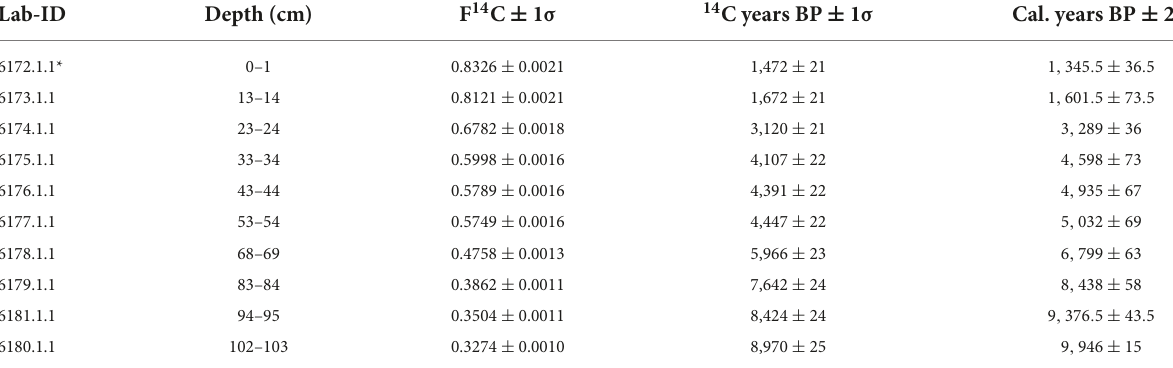
TABLE 1 14 C dating results for sediment core EN18224-4.